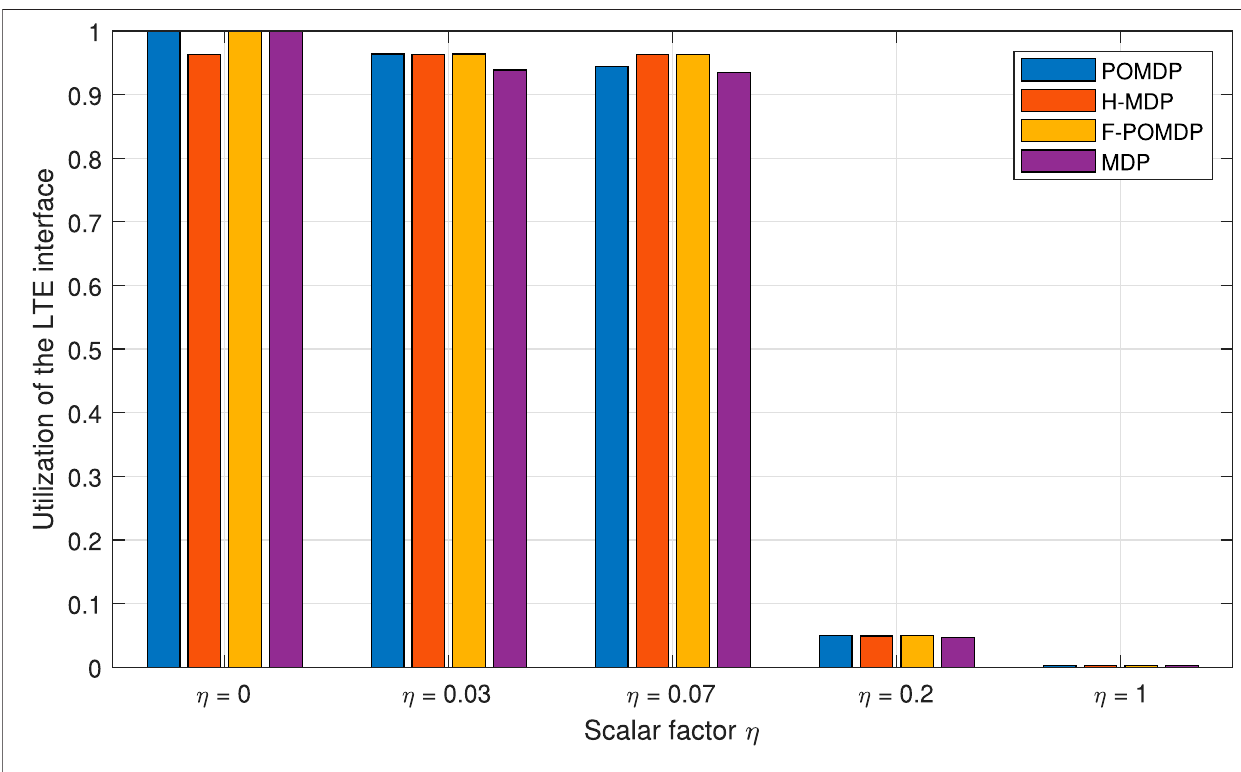
FIGURE 7 | Portion of time spent using the LTE interface i (cid:2)